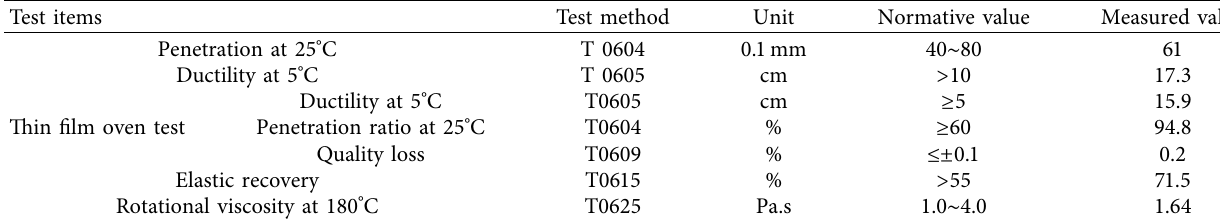
Table 3: Properties of rubber asphalt.